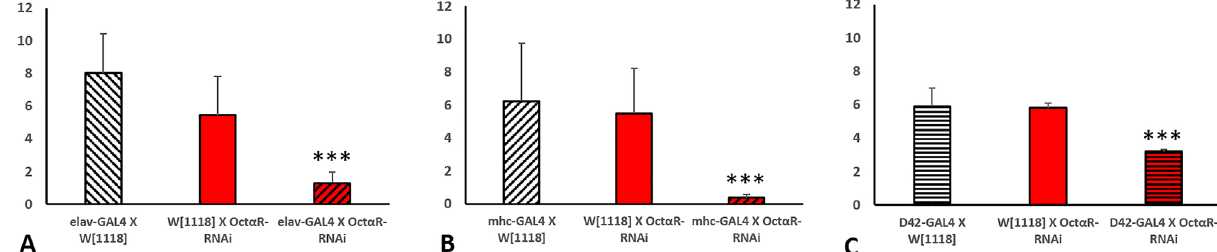
Figure 4. The climbing speed of OctαR -deficient adult Drosophila males (N = 10) as compared to controls. The experiment was performed in triplicate. RNAi-mediated gene kockdown was directed to the nervous system